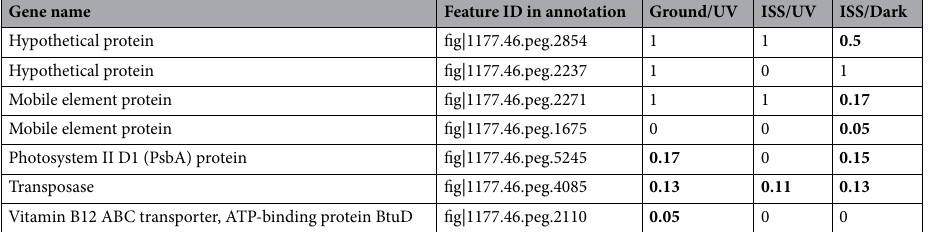
Table 2. Gene-by-gene Ka/Ks ratios. Ka non-synonymous variant, Ks synonymous variant, ISS international space station, UV ultraviolet light, Ground/UV earth with UV exposure, ISS/UV ISS with UV exposure, ISS/ Dark ISS without UV exposure. Significant values are in